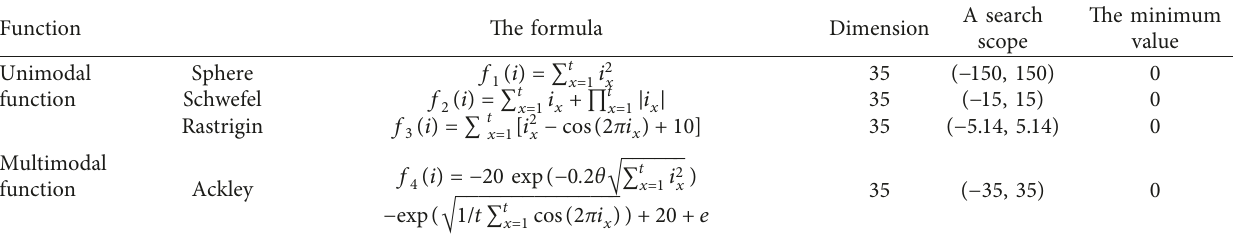
Table 1: Benchmark functions.